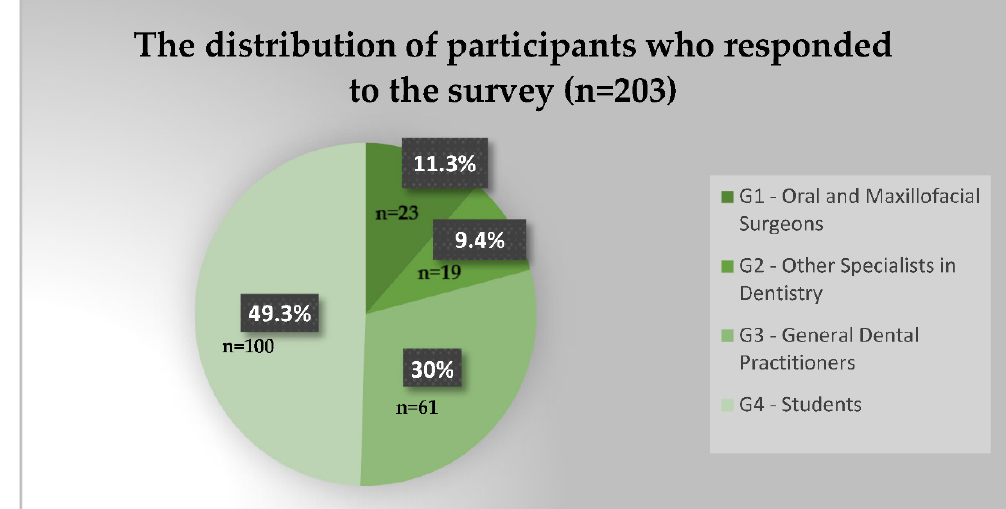
Figure 1. The distribution of participants who responded to the survey.